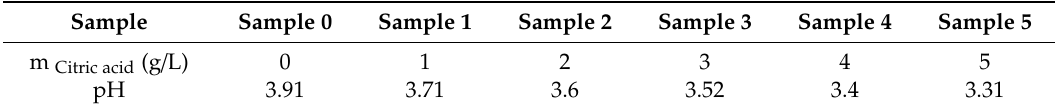
Figure 11. The polymeric anthocyanin content was at room temperature and at 45 °C.